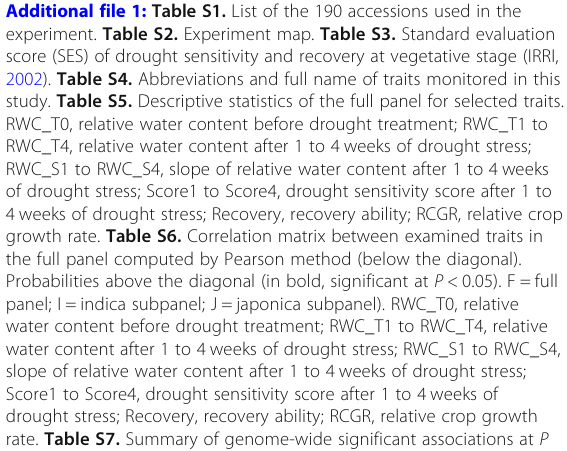
Additional file 1: Table S1. List of the 190 accessions used in the experiment. Table S2. Experiment map. Table S3. Standard evaluation score (SES) of drought sensitivity and recovery at vegetative stage (IRRI, 2002). Table S4. Abbreviations and full name of traits monitored in this study. Table S5. Descriptive statistics of the full panel for selected traits. RWC_T0, relative water content before drought treatment; RWC_T1 to RWC_T4, relative water content after 1 to 4 weeks of drought stress; RWC_S1 to RWC_S4, slope of relative water content after 1 to 4 weeks of drought stress; Score1 to Score4, drought sensitivity score after 1 to 4 weeks of drought stress; Recovery, recovery ability; RCGR, relative crop growth rate. Table S6. Correlation matrix between examined traits in the full panel computed by Pearson method (below the diagonal). Probabilities above the diagonal (in bold, significant at P < 0.05). F = full panel; I = indica subpanel; J = japonica subpanel). RWC_T0, relative water content before drought treatment; RWC_T1 to RWC_T4, relative water content after 1 to 4 weeks of drought stress; RWC_S1 to RWC_S4, slope of relative water content after 1 to 4 weeks of drought stress; Score1 to Score4, drought sensitivity score after 1 to 4 weeks of drought stress; Recovery, recovery ability; RCGR, relative crop growth rate. Table S7. Summary of genome-wide significant associations at